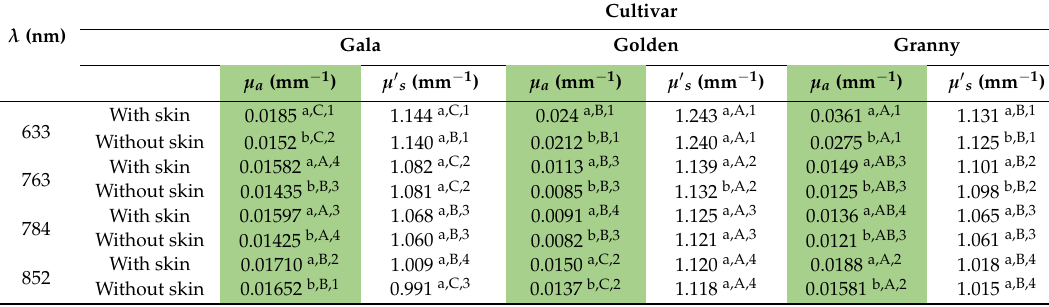
Table 2. Retrieved optical properties of three apple cultivars (Royal Gala, Golden Delicious and Granny Smith) with and without skin, irradiated at four wavelengths (633, 763, 784 and 852 nm).